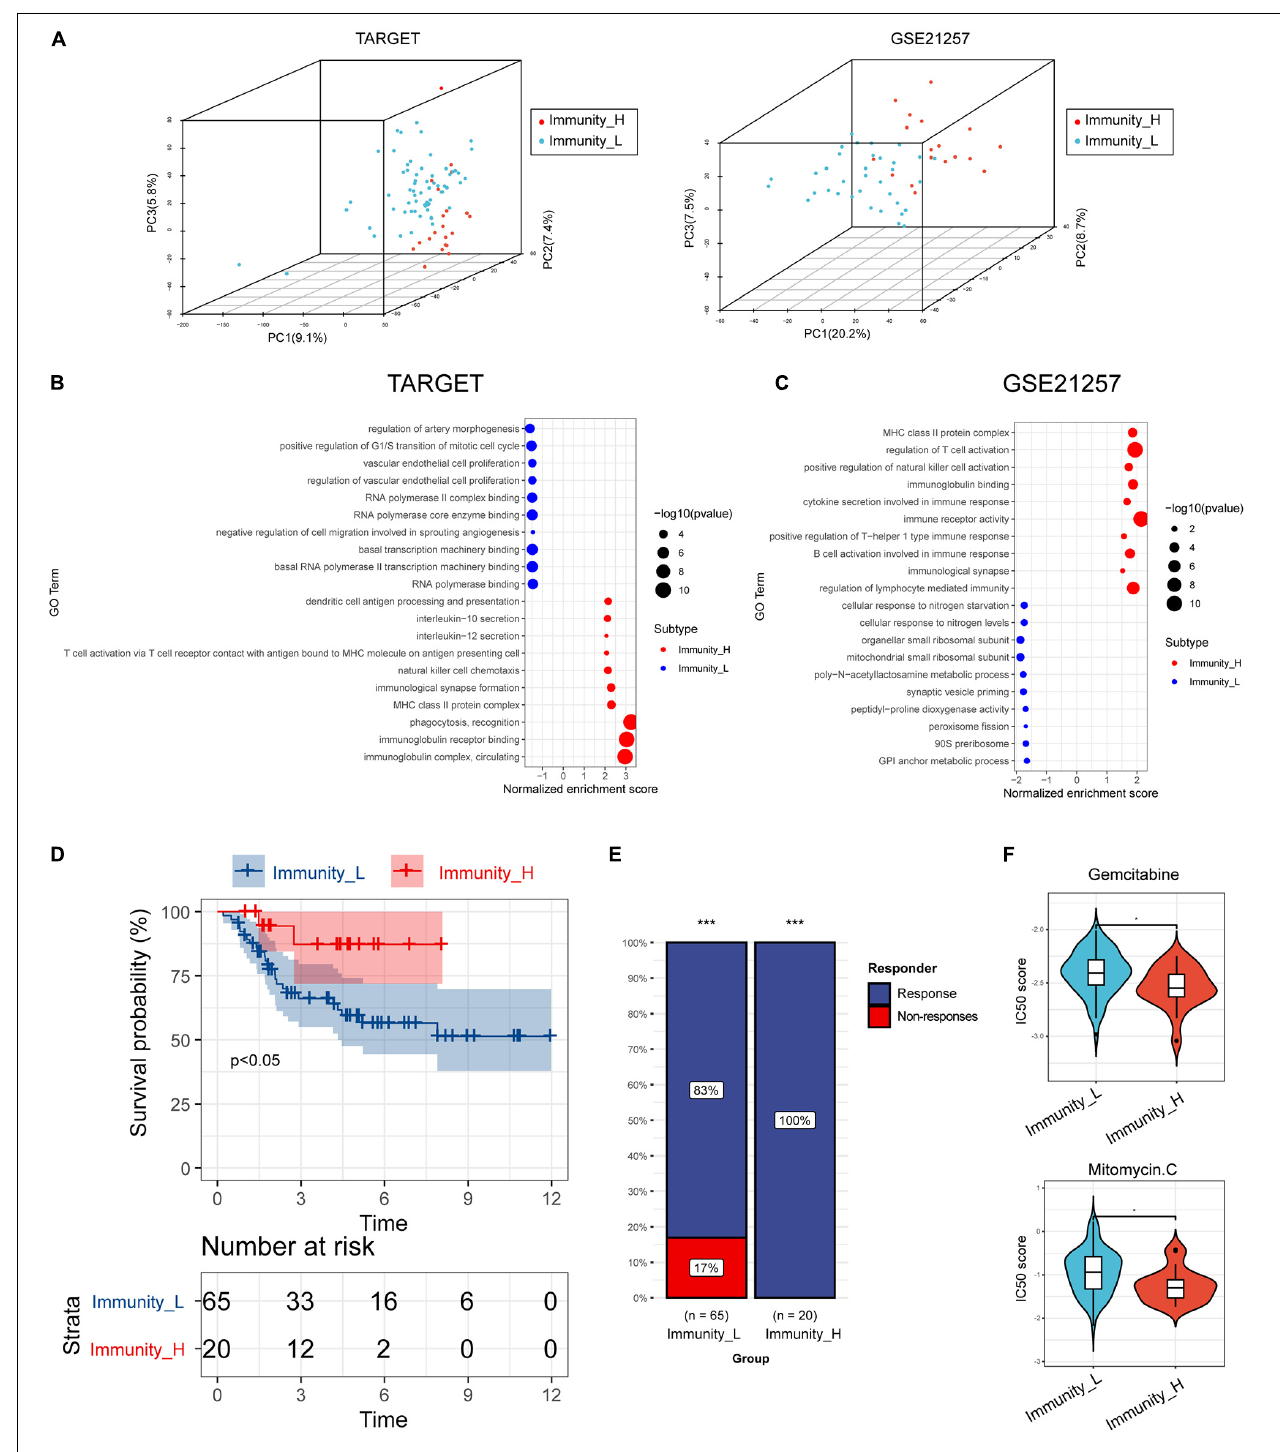
FIGURE 2 | (A) Principal component analysis plots. Red dots represent Immunity_H samples, and blue dots represent Immunity_L samples; (B,C) GSEA identified differential immune-related signaling cascades enriched in Immunity_H, as well as Immunity_L subtypes in TAGRT and GSE21257 datasets. Size of dots represented -log10 (p-value); (D) Kaplan–Meier curves of OS in Immunity_H and Immunity_L subtypes; (E) response rate to immunotherapy predicted by TIDE (a computational framework developed to evaluate potential of tumor immune escape from gene expression profiles of cancer samples: http://tide.dfci.harvard.edu/); (F) half-maximal inhibitory concentration scores of gemcitabine and mitomycin C in immunity_H and immunity_L subtypes. * p < 0.05, *** p < 0.001, and **** p < 0.0001.